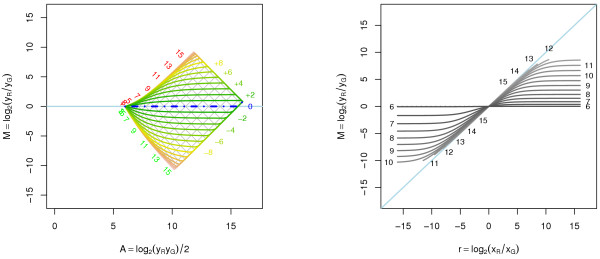
Curve-fit normalization of affine transformed data. Curve-fit normalization of A1
 MathType@MTEF@5@5@+=feaafiart1ev1aaatCvAUfeBSjuyZL2yd9gzLbvyNv2CaerbwvMCKfMBHbqedmvETj2BSbWenfgDOvwBHrxAJfwnHbqeg0uy0HwzTfgDPnwy1aqee0evGueE0jxyaibaieYdOi=BH8vipeYdI8qiW7rqqrFfpeea0xe9Lq=Jc9vqaqpepm0xbbG8FasPYRqj0=yi0lXdbba9pGe9qqFf0dXdHuk9fr=xfr=xfrpiWZqaaeaabiGaaiaacaqabeaadaqacqaaaOqaaGWaaiab=bq8bnaaBaaaleaatCvAUfKttLearCWrP9MDH5MBPbIqV92AaGqbaiab+fdaXaqabaaaaa@43C0@ transformed data. Left: Log-ratios as a function of log-intensities for different fold changes. Note that the distance between up- and down-regulated genes at any intensity is the same before and after the normalization. Right: Normalized log-ratios versus true log-ratios. We see that intensity-dependent artifacts have been removed for the observed and true log-ratios where all curves intersect (here at (0, 0)).